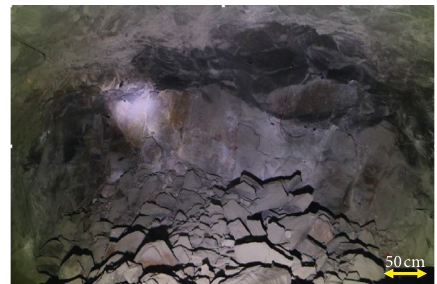
Figure 10: Blasting effect of single-wedge cutting.